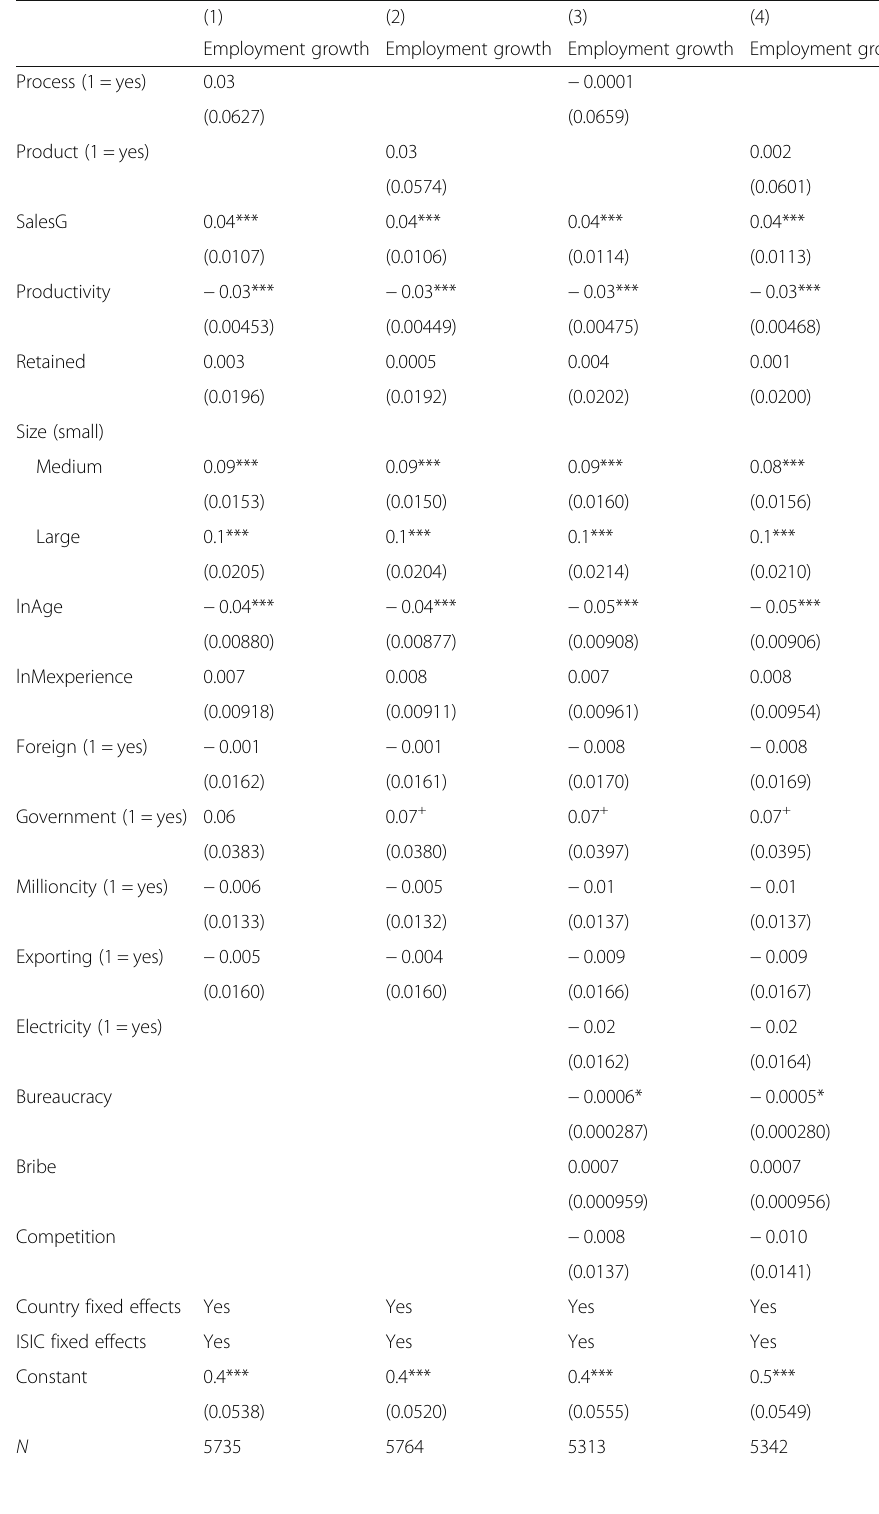
Table 8 Instrumental variables (2SLS)